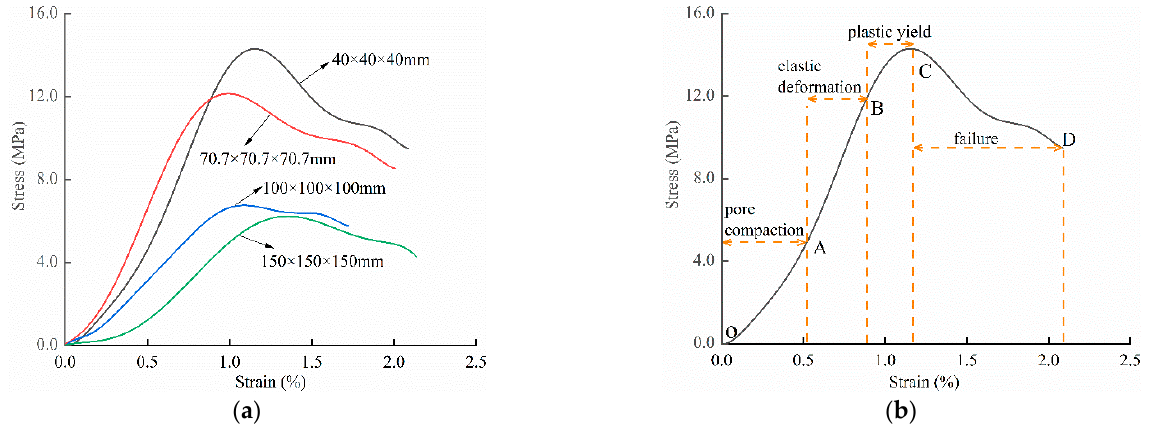
Figure 6. ( a ) Stress–strain curve and ( b ) stage segmentation of backfills with different sizes.